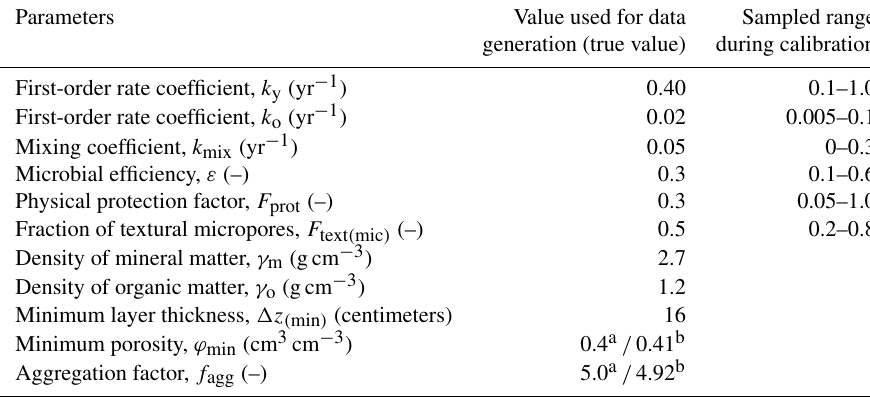
Table 2. Parameter values used to generate the synthetic data and the sampled range in the model calibration.